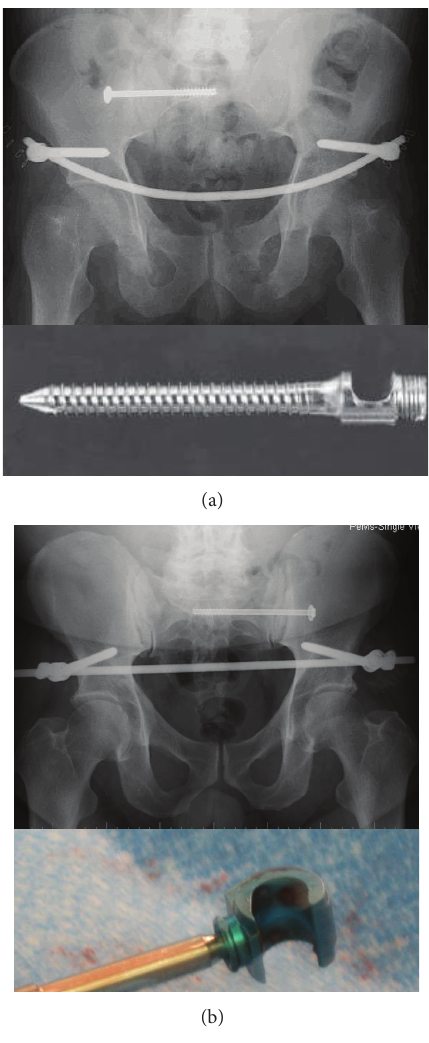
Figure 1: X-rays with an (infix) with (a) a monoaxial system and (b) a polyaxial system reinforced with